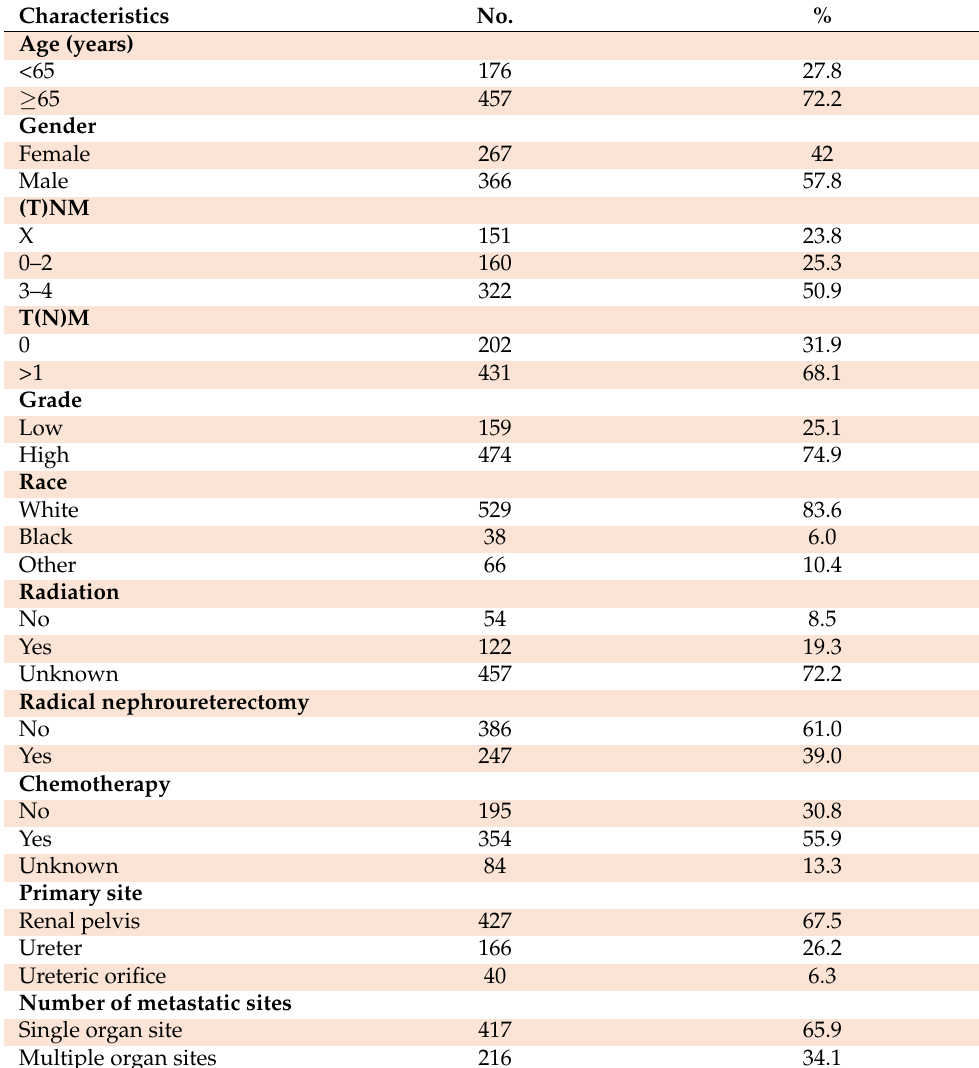
Table 1. Baseline characteristics of patients with metastatic